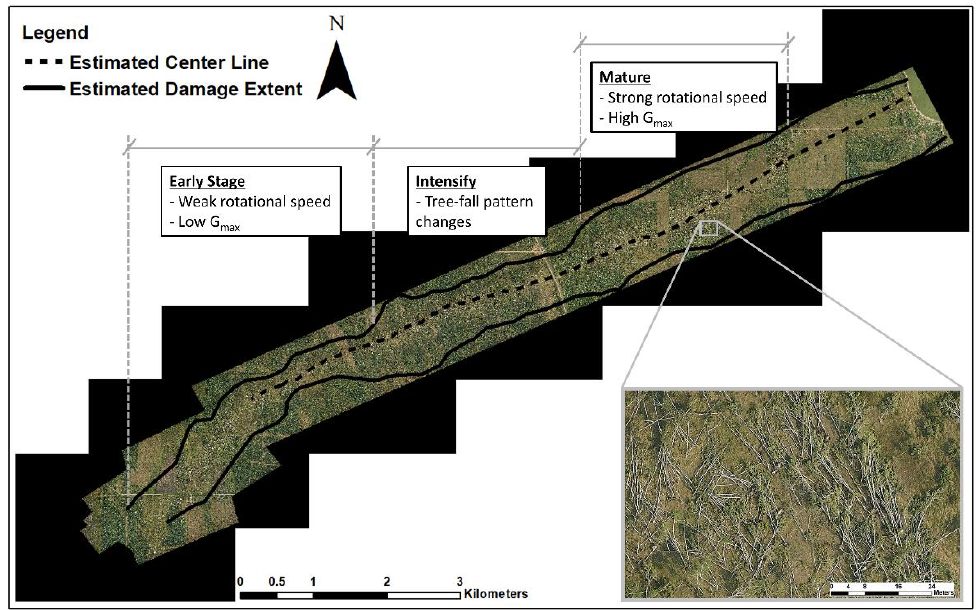
Figure 3. Alonsa tornado track orthomosaic .